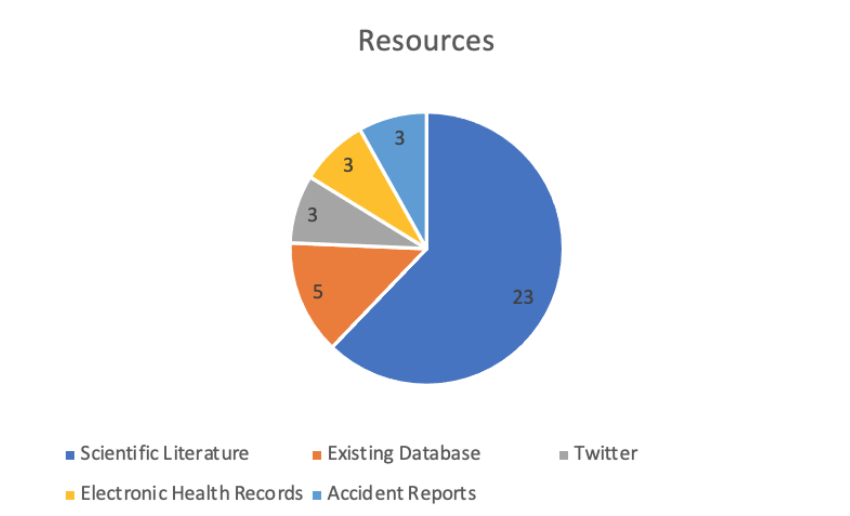
Figure 3. A chart showing the different types of resources used in the selected articles.